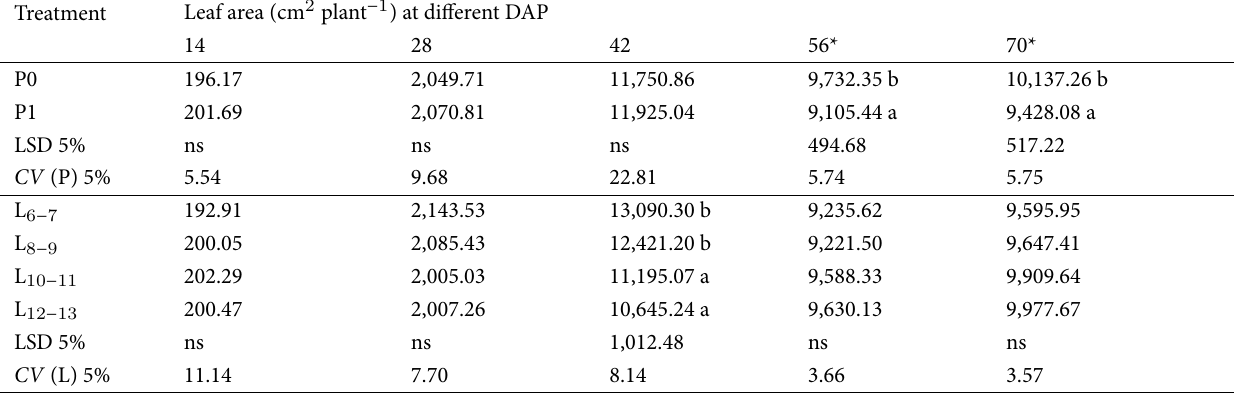
Numbers with the same letter on the same column are not significantly different in the LSD test of 5%. DAP – days after planting; * leaf area after trimming at 45 DAP.